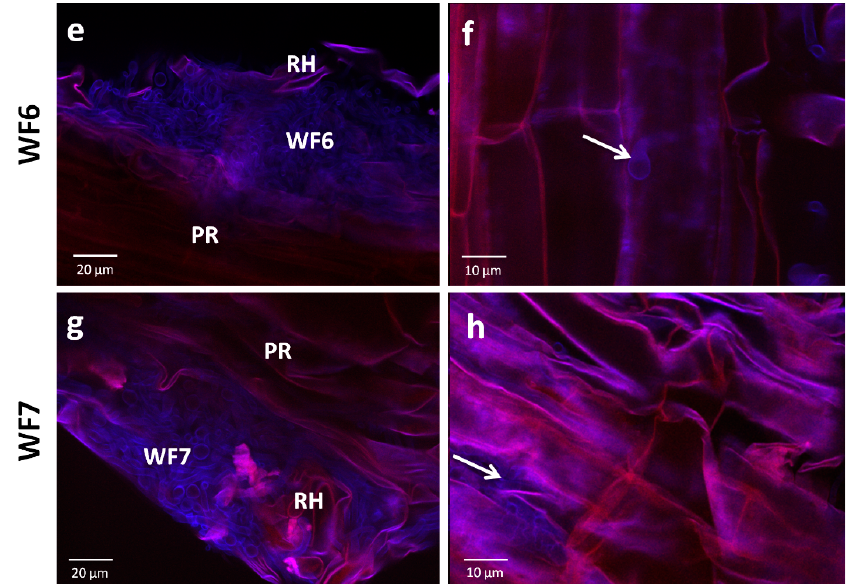
Figure 3. Test for the ability of the putative fungal endophytes to colonize finger millet roots using confocal scanning laser microscopy. ( a – b ) Representative pictures of root tissues inoculated with the buffer control; ( c – h ) Representative pictures of root tissues inoculated with each putative fungal endophyte as indicated. Fungi fluoresce purple-blue due to staining with calcofluor. Plant tissues appear red due to auto-fluorescence. White arrows point to fungi inside the tissues. Abbreviations: PR, primary root; RH, root hair.